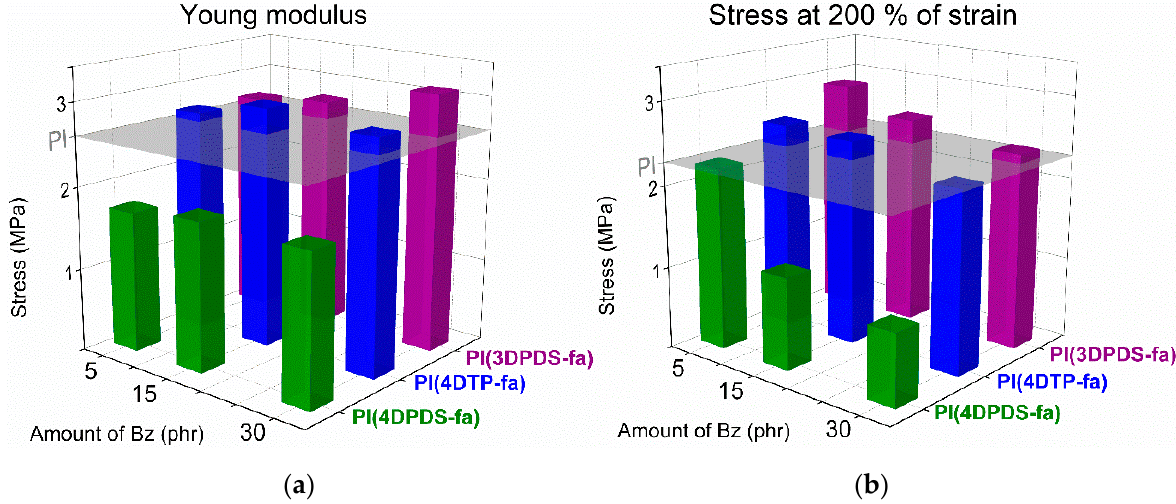
Figure 7. ( a ) Young modulus as a function of the amount of benzoxazine; ( b ) Stress at 200% of strain as a function of the amount of benzoxazine.